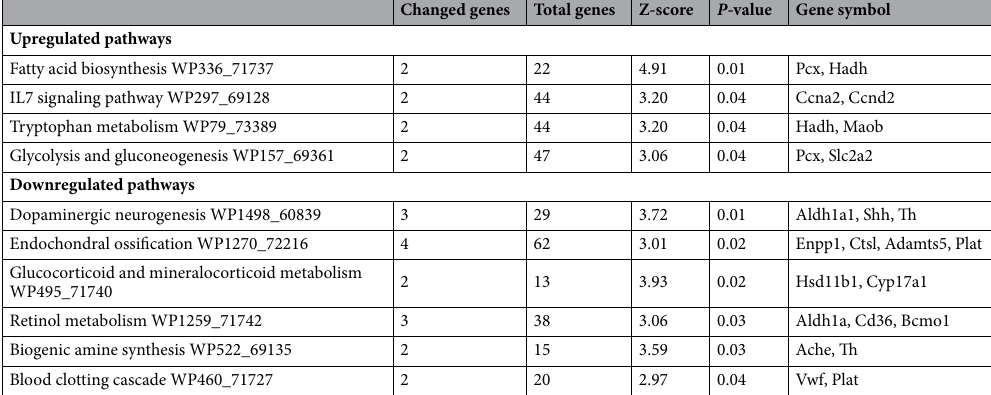
Table 2. Up- and downregulated pathways in the luseogliflozin-treated group. P values were determined using two-tailed Fisher’s exact